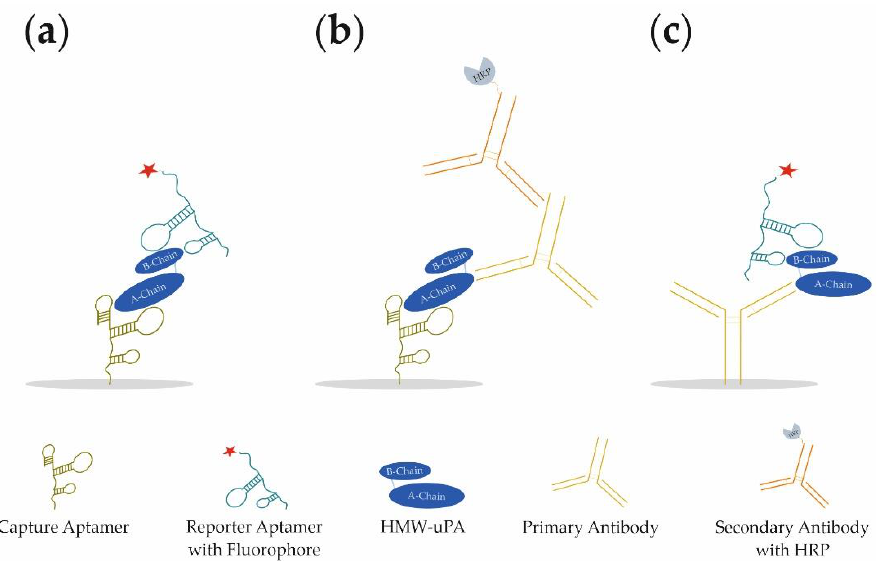
Figure 1. Schematic illustration of the three different sandwich assay formats developed for the detection of different forms of human urokinase. ( a ) Aptamer – Target – Aptamer, ( b ) Aptamer – Target – Antibody, and ( c ) Antibody – Target – Aptamer.